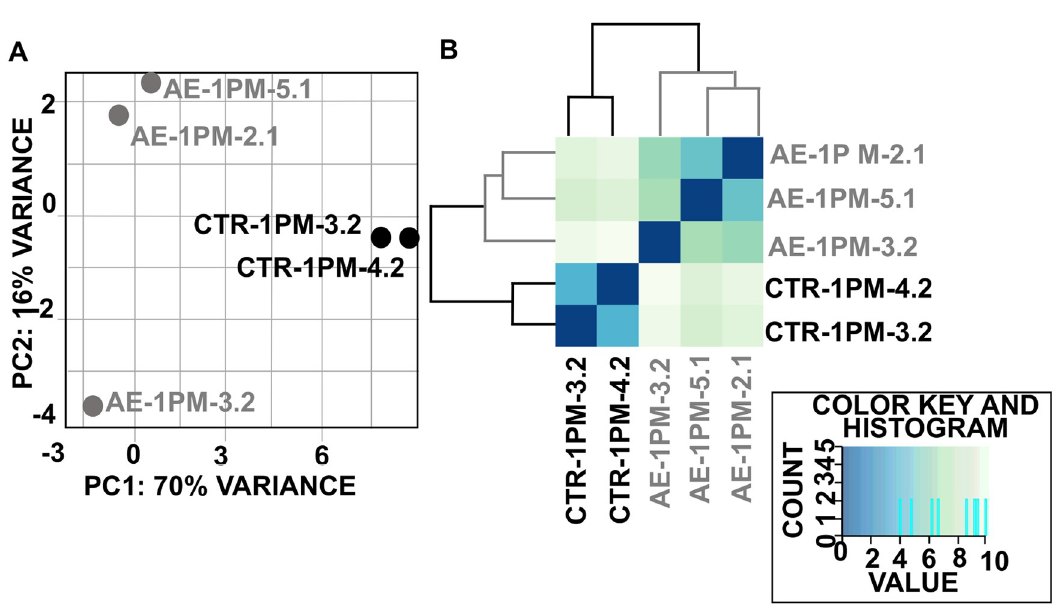
Fig 2. Principal component analysis (A) and (B) hierarchical clustering both revealed a clear separation between hepatic miRNA profiles from infected and uninfected mice. All the 699 miRNAs, identified in this study, with the normalized read-count in each animal group, are listed in S3 Table.